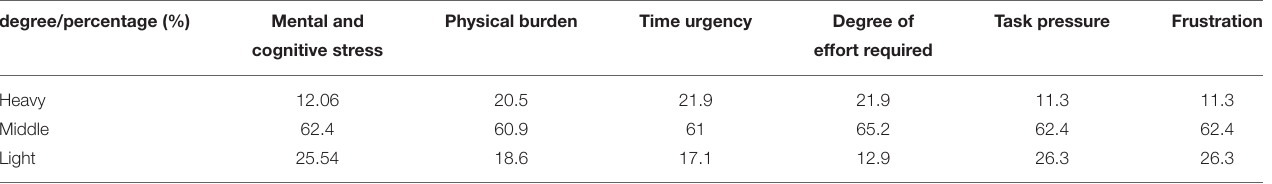
True evaluation